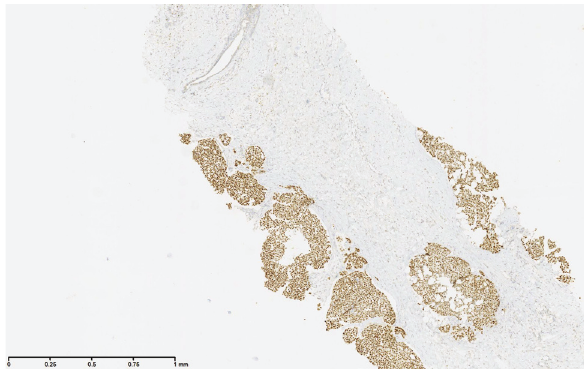
Figure 2B. Biopsy of the breast metastasis. 4× magnification. Positive staining PAX8 on immunohistochemistry: Positive